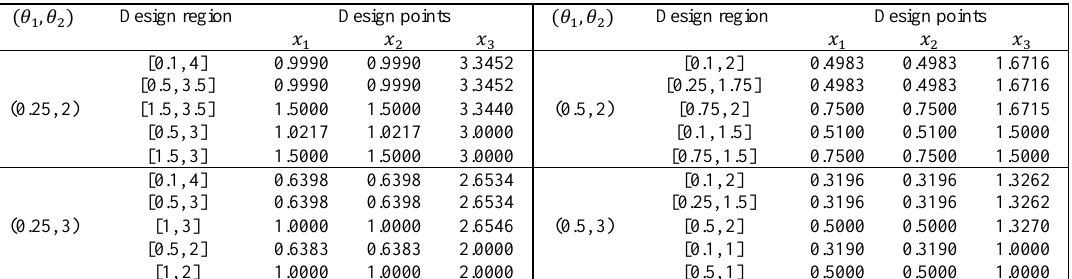
Table 10. E-optimal designs for generalized Pareto model with three support points having